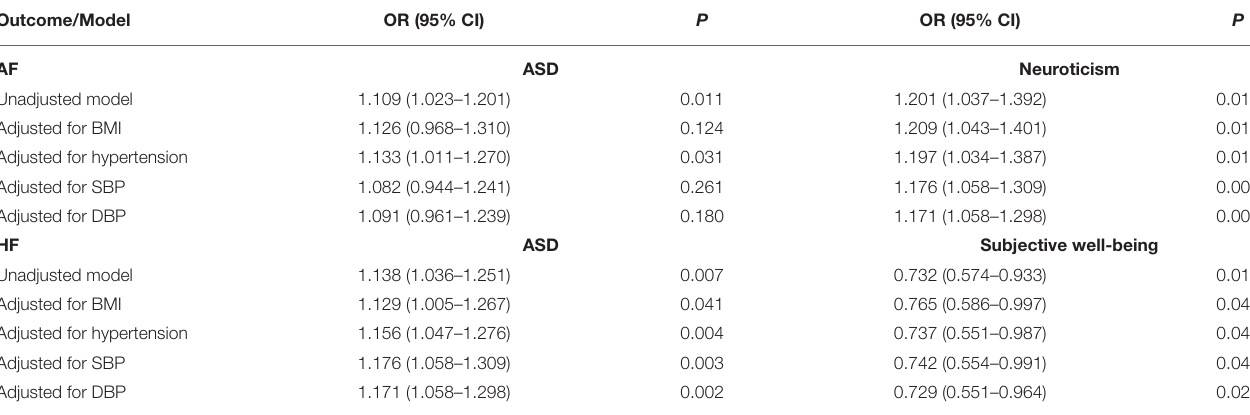
TABLE 3 | Multivariable Mendelian randomization associations of autism spectrum disorder, neuroticism, and subjective well-being with atrial fibrillation and heart failure risk adjusting for body mass index and blood pressure measurements.